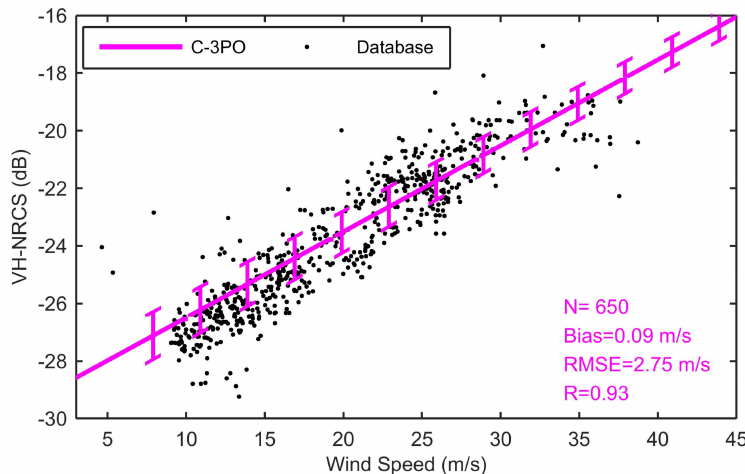
Figure 2. C-3PO hurricane wind retrieval model. The magenta line is for the middle incidence angle (34.5 ◦ ), as well as the bars for the incidence angle ranges (from 19.5 ◦ to 49.5 ◦ ) of the RADARSAT-2 ScanSAR